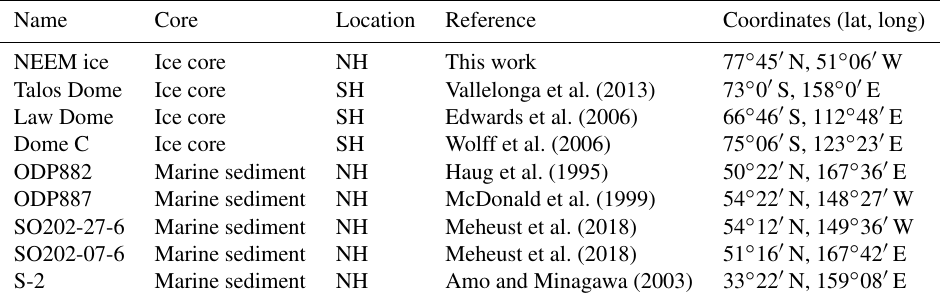
Table 4. Summary of locations and data sources for all the cores (both ice and sediment cores) discussed in the text. (NH stands for Northern Hemisphere, and SH stands for Southern